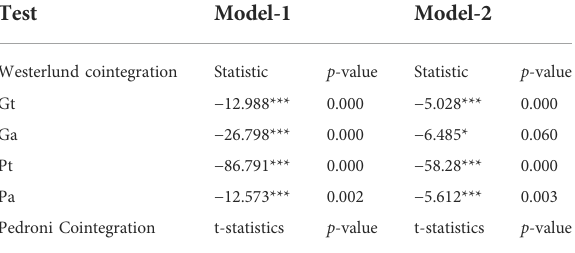
TABLE 4 Panel cointegration